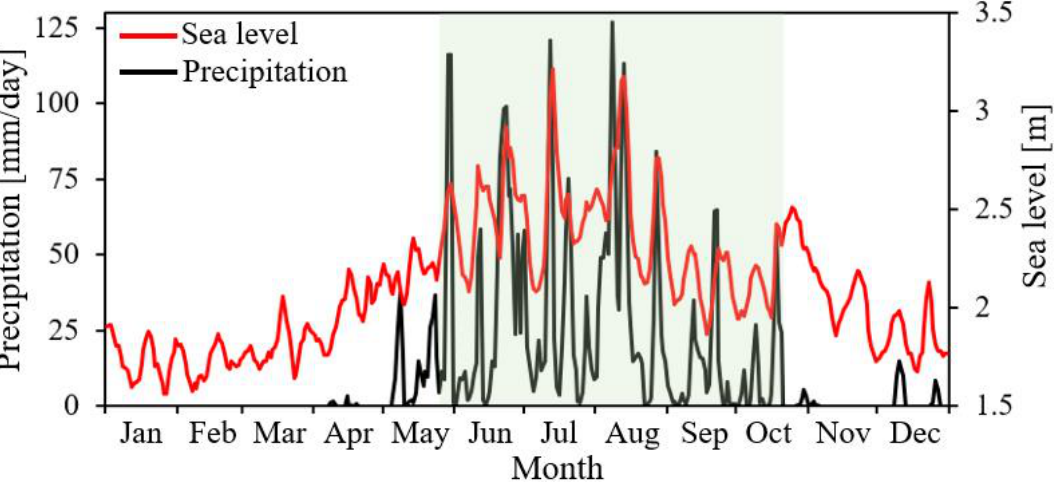
Figure 3. The time series of daily observed sea level (red) at Cox’s Bazar station and area average precipitation (black) near Cox’s Bazar area (22°– 22.5° N and 21.5° – 22.5° E) in 1999. The shaded period represents the period for the monsoon season (late May to early October).